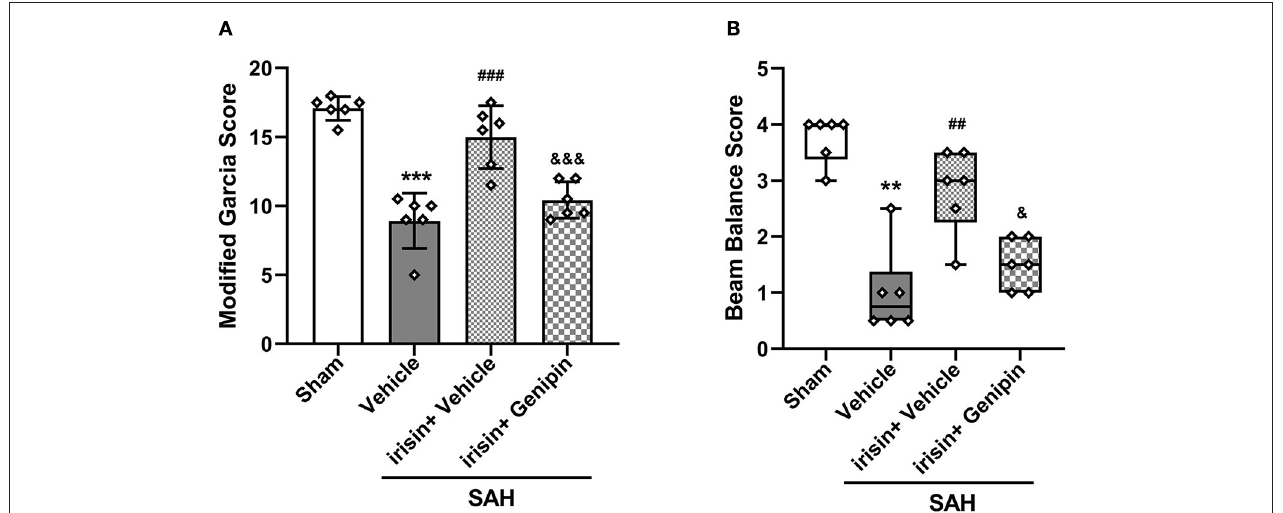
FIGURE 7 | Inhibition of UCP-2 pathway blunted the beneficial effect of irisin treatment on short-term neurologic function after SAH. (A,B) Genipin significantly blunted the protective effect of irisin treatment on neurological deficits at 24h after SAH, n = 6 for each group. The modified Garcia test scores were represented as mean ± SD; the one-way ANOVA was used followed by the Tukey’s HSD post-hoc test and the Holm–Bonferroni correction method. The beam balance test scores were represented as median 25th − 75th percentiles, and the Mann–Whitney U -test and the Kruskal–Wallis test followed by the Steel–Dwass method of multiple comparisons were used to analyze the difference between groups. ** P < 0.01, *** P < 0.001 vs. Sham group; ## P < 0.01, ### P < 0.001 vs. SAH + Vehicle group; & P < 0.05, &&& P < 0.001 vs. SAH + irisin + Vehicle group. Vehicle group, sterile 0.9% of NaCl; SAH, subarachnoid